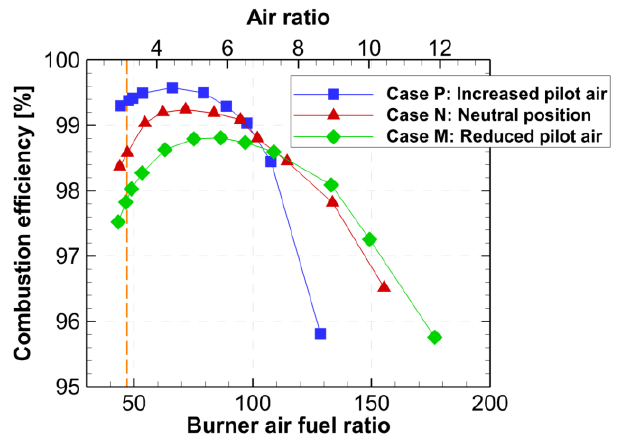
Figure 8. Combustion efficiency under idling conditions. (Copyright by ASME — "Effects of Fluidic Control of Air-Flow Distribution on Staged Lean Jet Engine Burner," by Yoshida, Schneider, Hassa, Paper No: GT2016-57453).